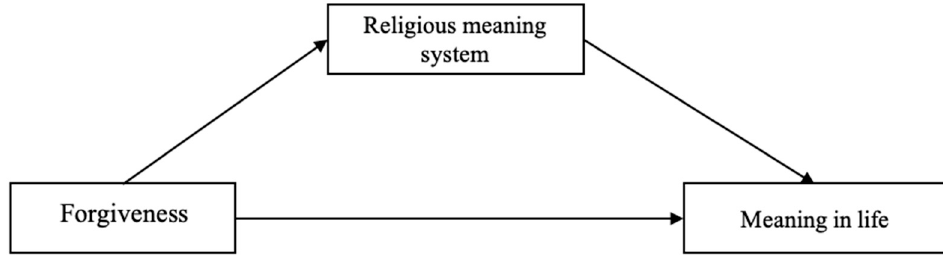
Figure 1. A conceptual model of the mediating role of the religious meaning system in the rela- tionship between forgiveness and meaning in life.